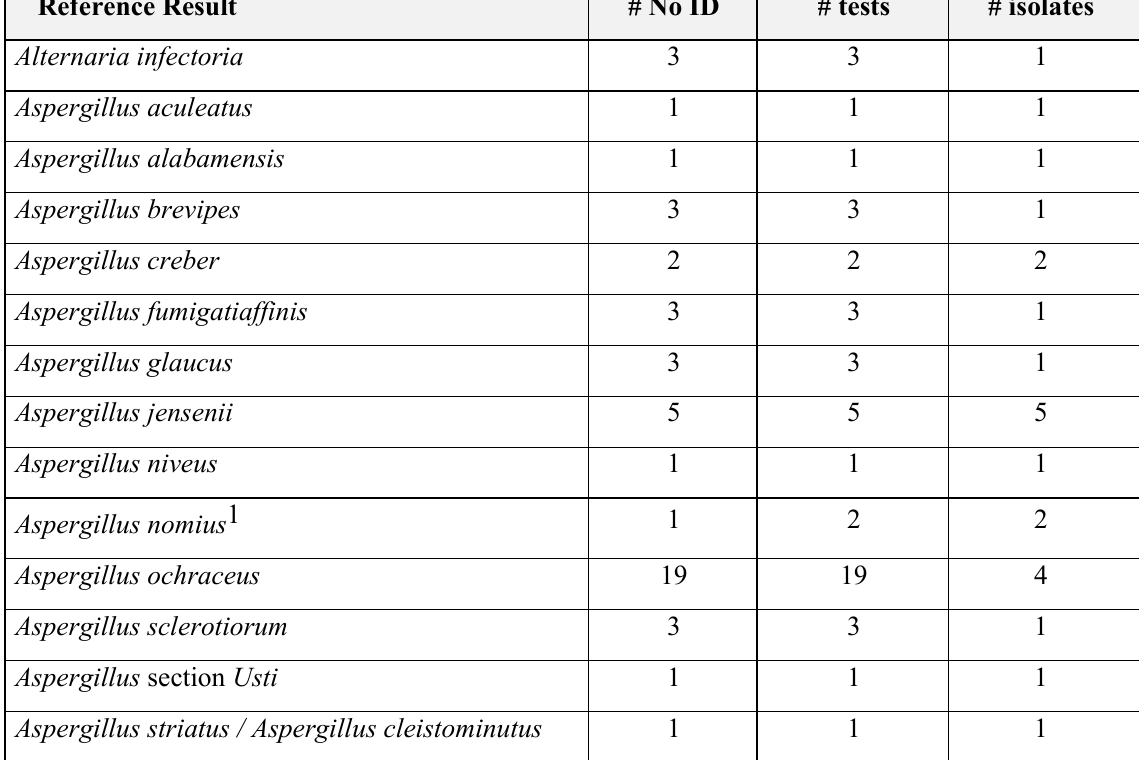
TABLE 8: Moulds tested; VITEK MS result ‘No Identification’ Reference